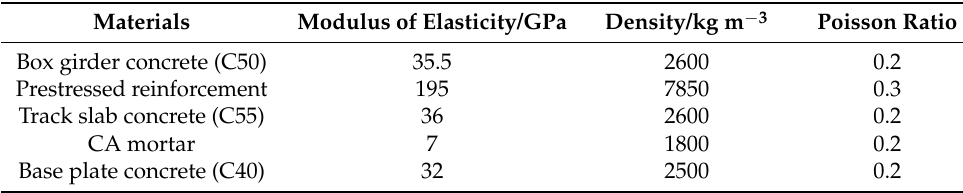
Table 3. Material parameters of CRTS II slab ballastless track.